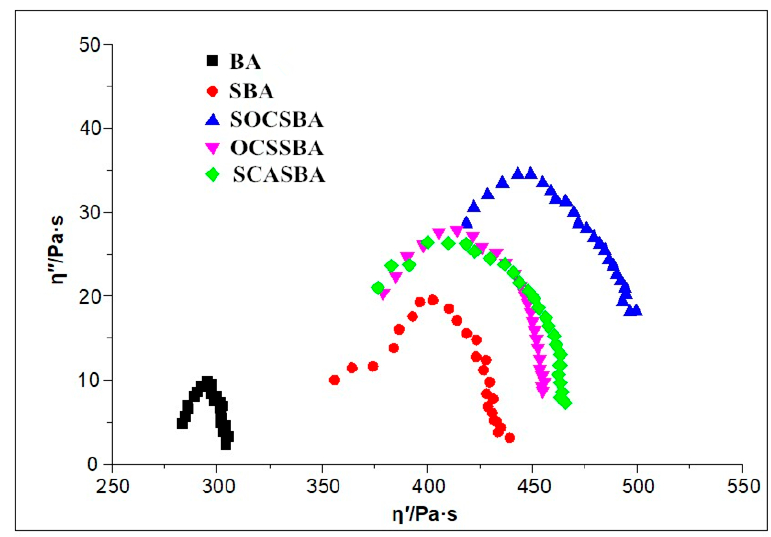
Figure 18. Cole–Cole diagrams of five asphalt binders at 76 °C.